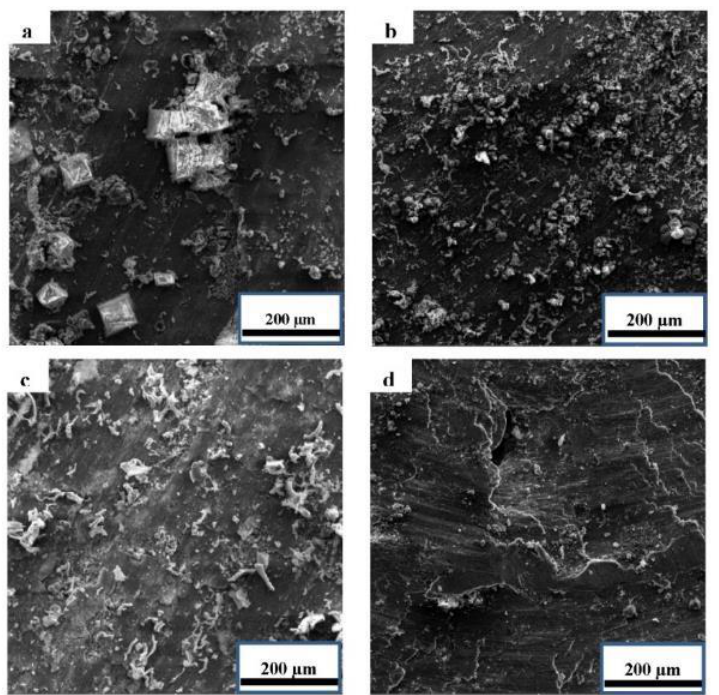
Fig. 19. SEM images of corroded samples in 3.5% NaCl. (a) Base material (as received), (b) Al 7075 + 3wt.% TiC, (c) Al 7075 + 6wt.% TiC and (d) Al 7075 + 9wt.%